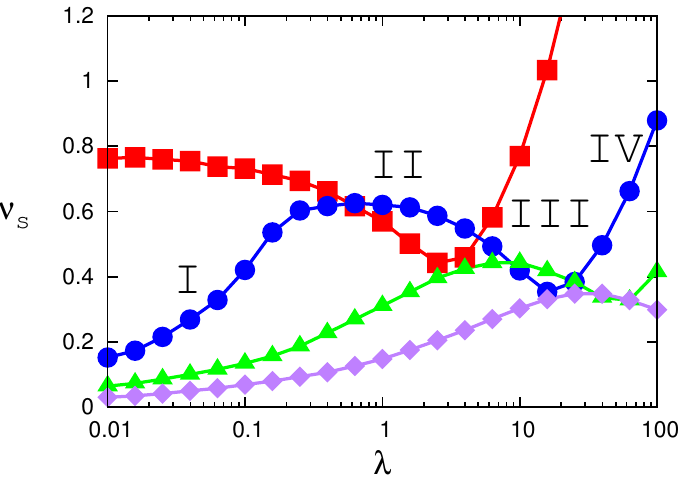
) for four different values of the Figure 1. Scaled saturation ion number ν s ( λ ) = N s ( λ ) / ( q 2 ˆ R 3 cut trap control parameter q as a function of loading rate λ . Red squares: q = 0.1; blue circles: q = 0.2; green triangles: q = 0.3; purple diamonds: q = 0.4. All four loading curves show at least three of the four dynamical regimes predicted in [13,14] and explicitly marked I, II, III, and IV in the case of the curve corresponding to q = 0.2 (blue circles). For increasing q we observe that the height of the plateaus decreases and the maxima of the plateaus shift over several orders of magnitude toward larger loading